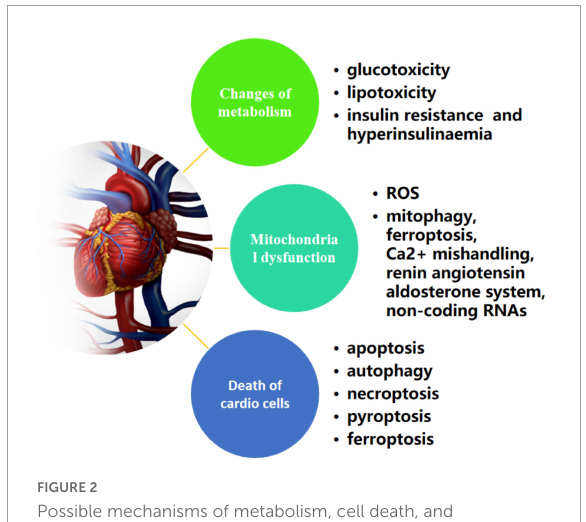
FIGURE2 Possible mechanisms of metabolism, cell death, and mitochondrial dysfunction in diabetic